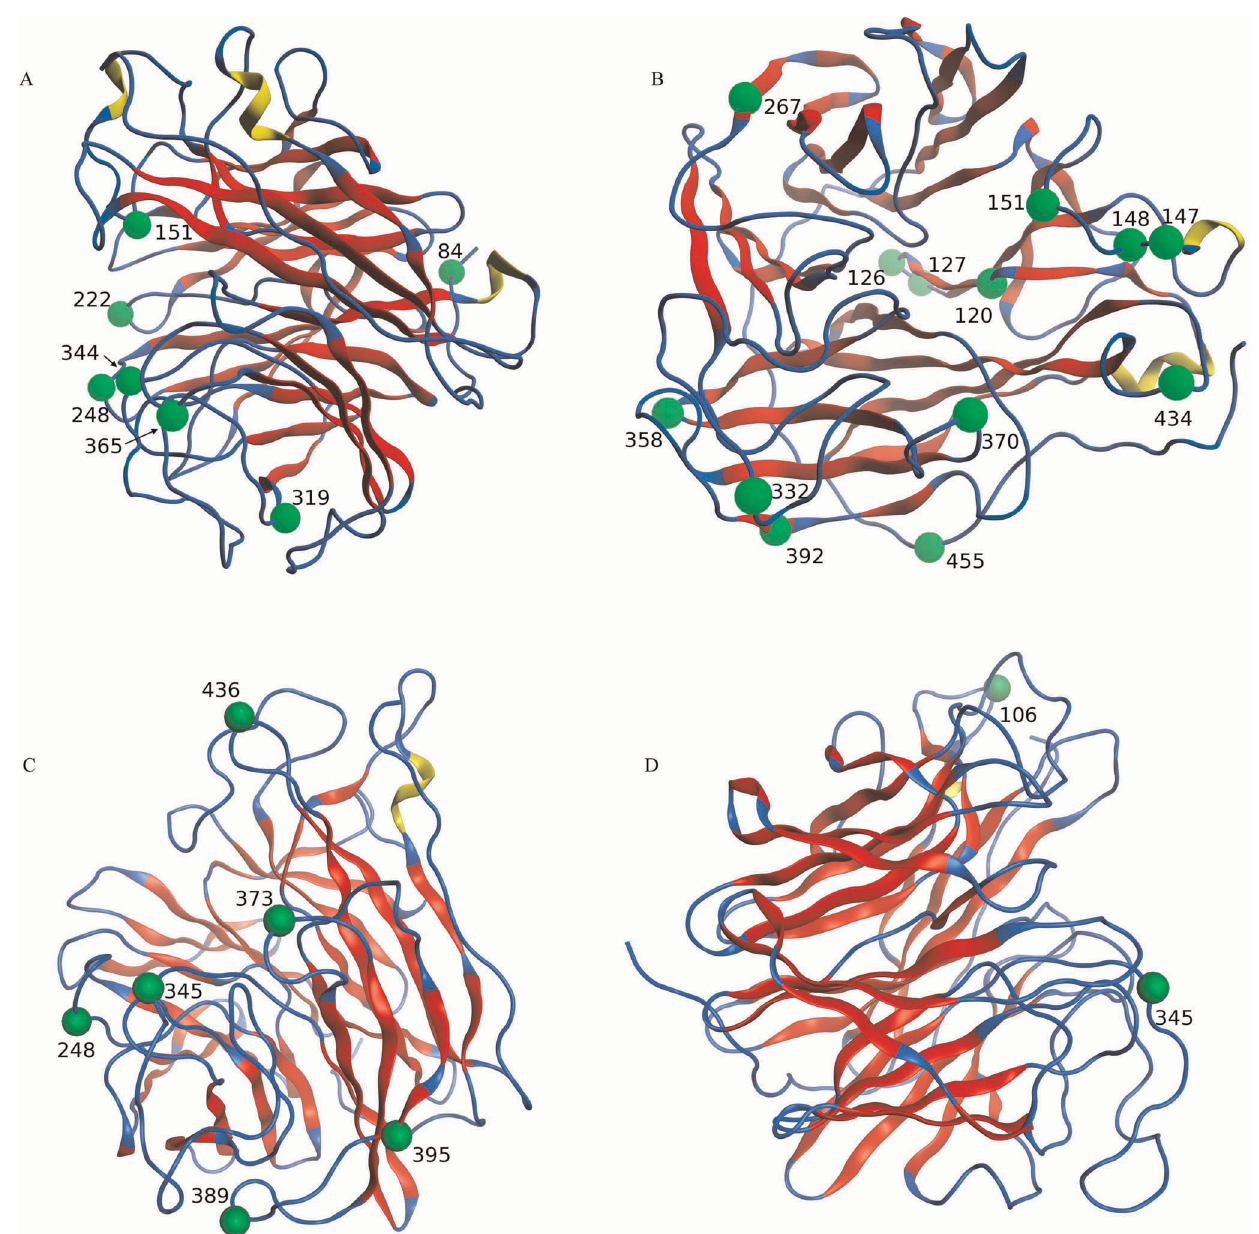
Figure 5. The structures and positive selection sites of human influenza neuraminidase. A: Influenza A human N1 neuraminidase (1C) (A/ Brevig Mission/1/18 H1N1, 1918 ‘‘Spanish flu’’, PDB ID: 3B7E); B: Influenza A human N2 neuraminidase (2B) (A/Tokyo/3/67 H2N2, 1967, PDB ID: 1IVG); C: Influenza B viral neuraminidase for Yam88 (B/Perth/211/2001, PDB ID: 3K36); D: Influenza B viral neuraminidase for Vic87 (B/Perth/211/2001, PDB ID: 3K36). The positive selection sites are denoted as green balls. Structural regions are denoted in different colors: yellow for alpha-helices, red for beta sheets, and blue for loops.